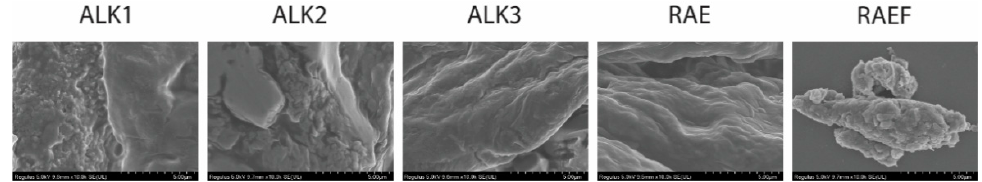
Figure 6. Peptides were assembled through incubation in PBS. Samples were dried and sputter ‐ coated with platinum before conducting SEM. All images are captured at a magnification of 10.0 k, and scale bars represent 5 μ m.